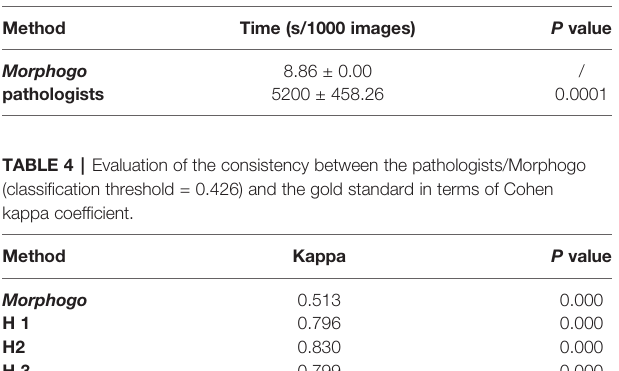
TABLE 3 | The time (s/1000 images) required for Morphogo and pathologists to identify and count metastatic cancer clusters from digital microscope imagines on the marrow smears.